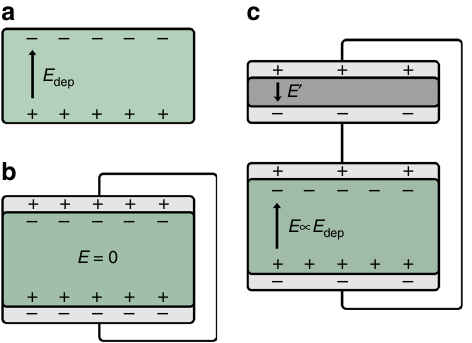
Fig. 8 Schematics of compensation of depolarization fi eld. a Depolarization fi eld in a free-standing ferroelectric material. b Ferroelectric-only capacitor with metal electrodes. c Ferroelectric capacitor with an additional serial